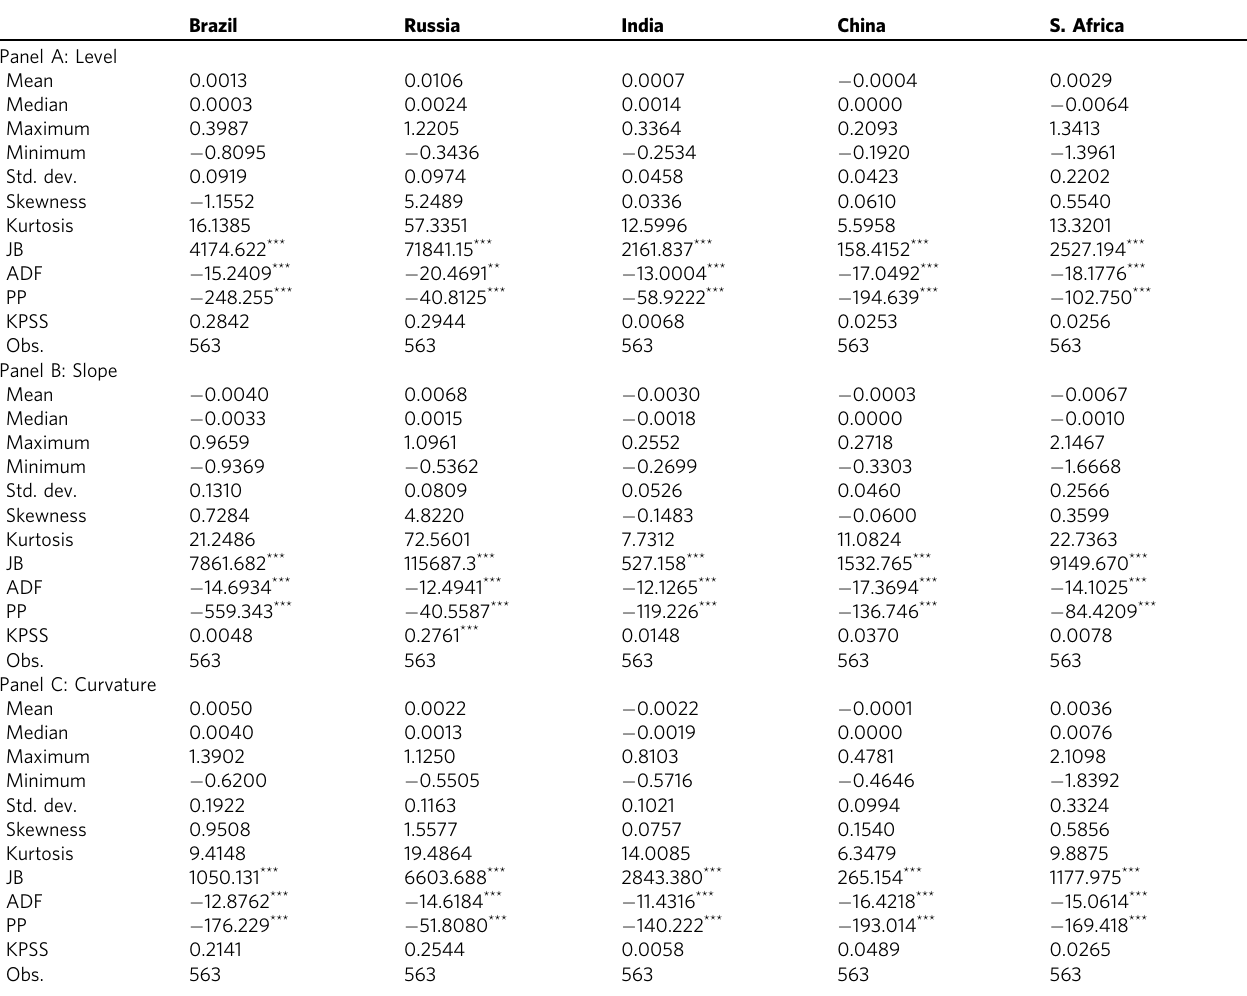
Table 1 Descriptive statistics of the components of the BRICS term